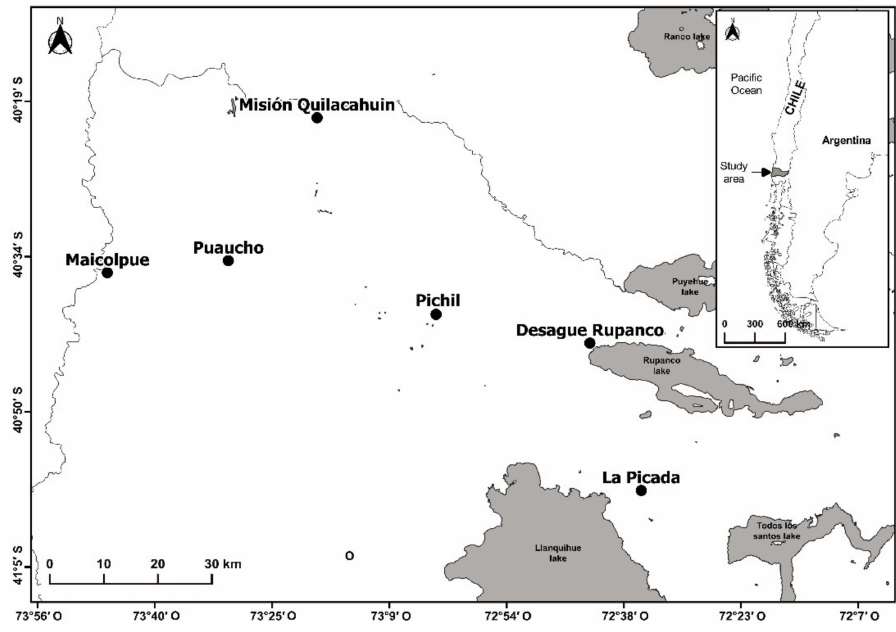
Figure 1. Study area. Six organizations were chosen to incorporate a longitudinal view from west to east in Los Lagos Region of southern Chile.